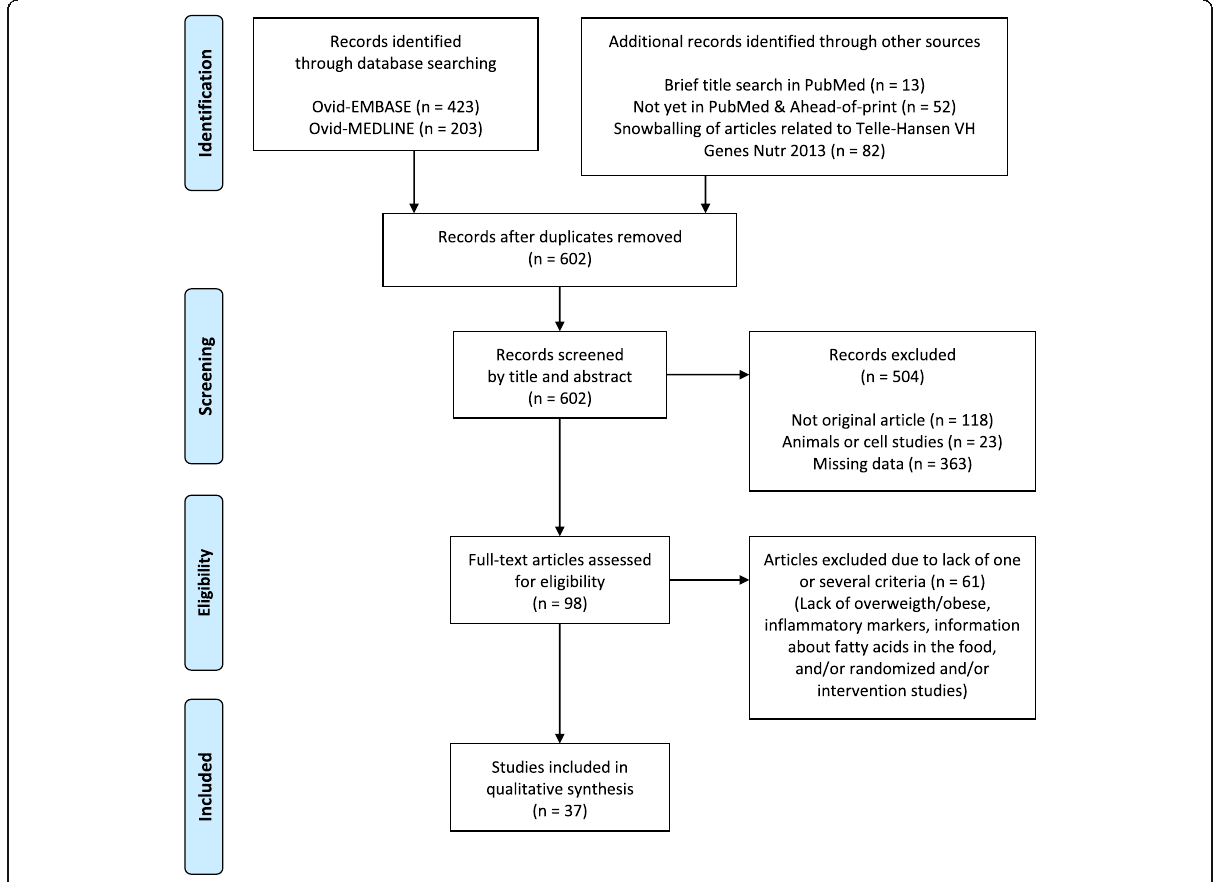
Fig. 1 Flow chart of the study